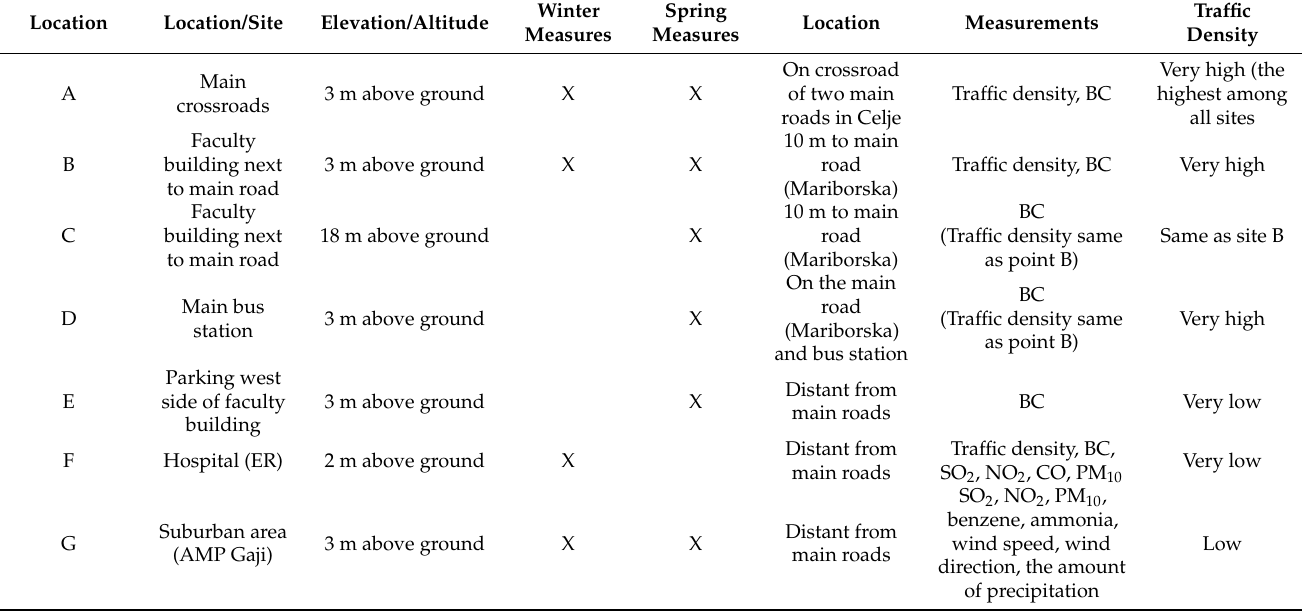
Table 1. Descriptions of measurement locations in